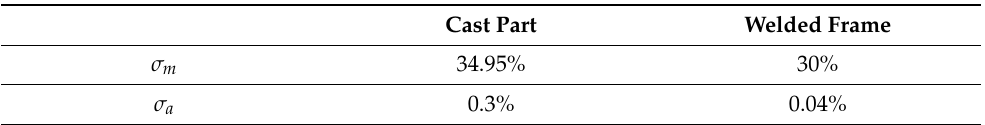
Table 4. Mean and alternating stress values on both parts [30] (stress values were scaled as percentage of yield points of materials). Cast Part Welded